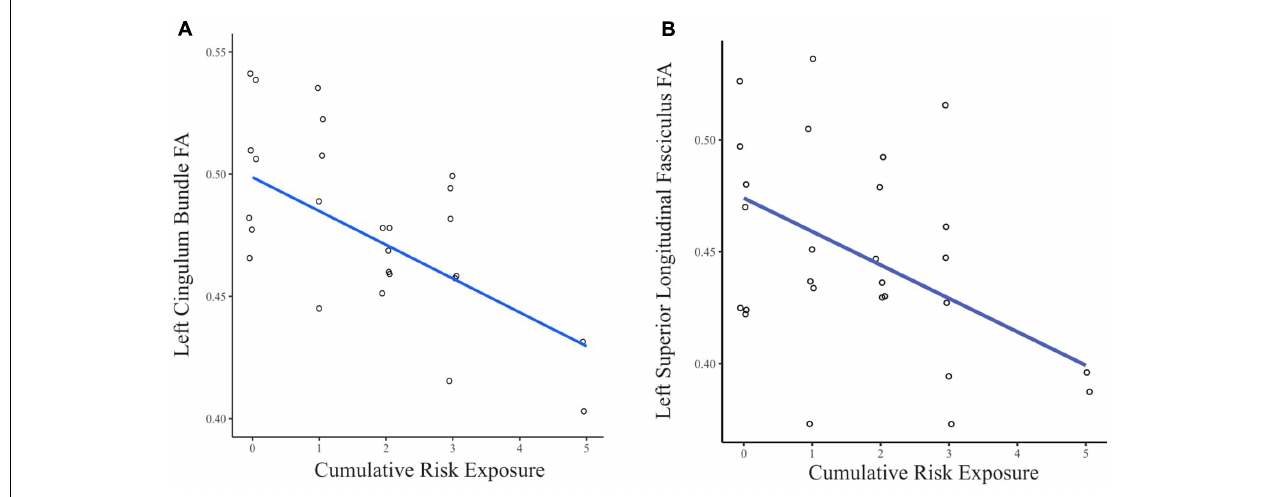
FIGURE 2 | (A) Scatter plot of the relationship between CR exposure and FA in the left cingulum bundle. (B) Scatter plot of the relationship between CR exposure and FA in the left superior longitudinal fasciculus. Data points are jittered to allow visualization of overlapping